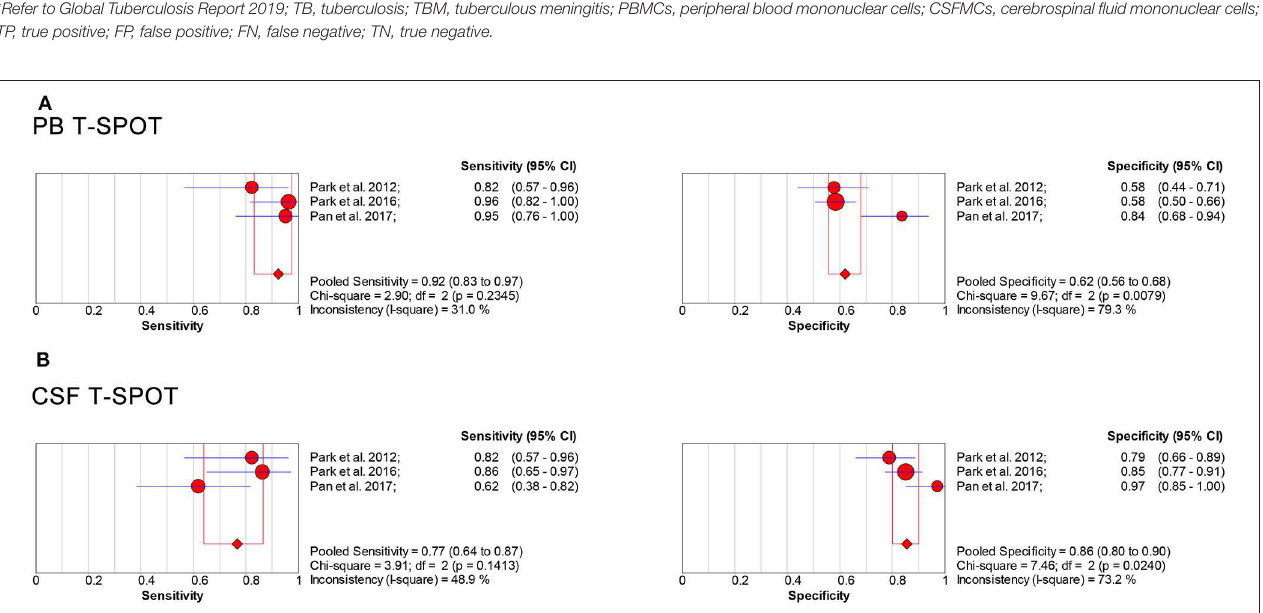
FIGURE 8 | Forest plot showing estimates of sensitivity and specificity for PB T-SPOT (A) and CSF T-SPOT (B) for the diagnosis of TBM when comparing microbiologically confirmed TBM with non-TBM. Solid dots represent the point estimates of sensitivity and specificity from each study. Size of solid dots reflects the total number of cases and controls. Error bars indicate 95% CI. Pooled results are shown as diamonds. PB, peripheral blood; CSF, cerebrospinal fluid; TBM, tuberculous meningitis; CI, confidence